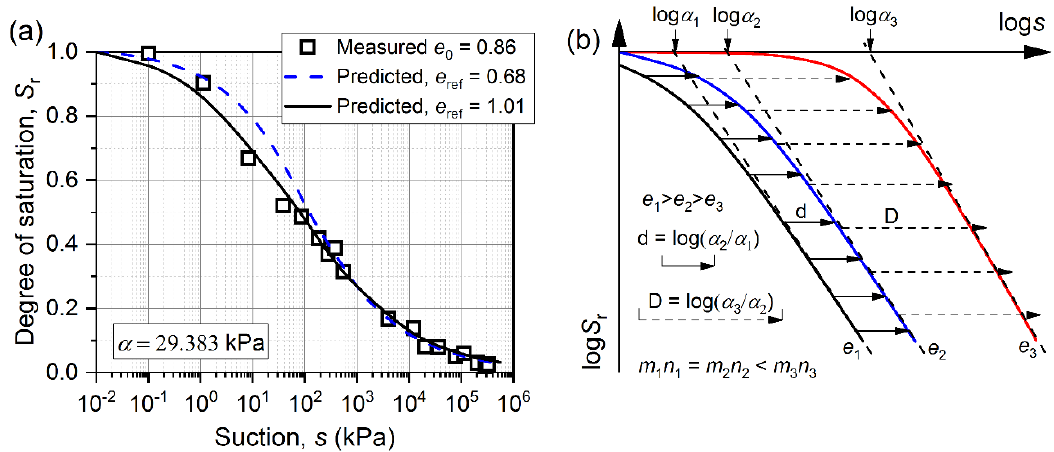
Figure 6. ( a ) Measured and predicted SWRC for silty sand at the initial void ratio, e 0 = 0.86; ( b ) Influence of reference SWRCs on predicted SWRCs.